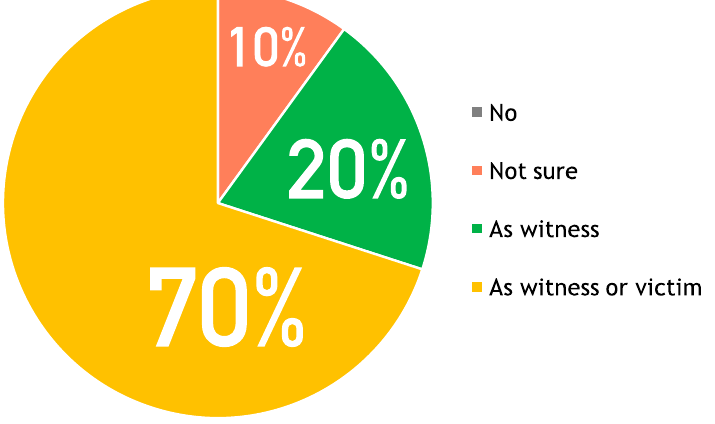
Figure 4. Overall user acceptance (would you use it?) of the proposed mobile application after the simulation.